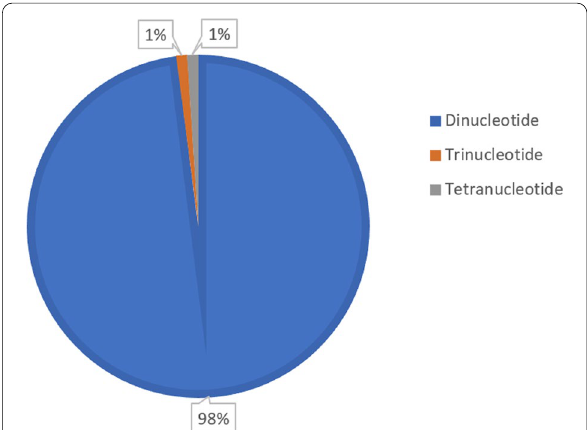
Fig. 2 Percentage of repeat motifs of the selected SSRs